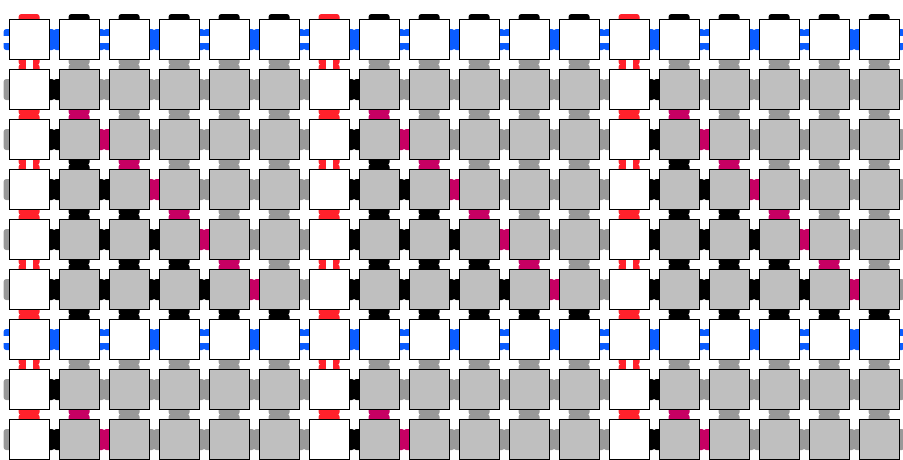
Fig. 3 Section of the checkerboard tiling Hamiltonian ’ s ground state. The white squares form borders, and in the interior, we place tiles simulating the evolution of a classical Turing